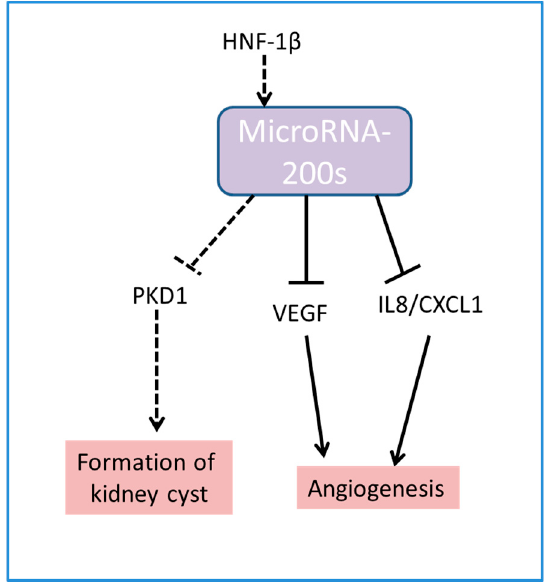
Figure 2. Schematic diagram showing miR-200s control cyst formation and angiogenesis. Dashed lines indicate the same pathway. HNF-1 β : hepatocyte nuclear factors 1 β , PKD1: polycystin I, VEGF: vascular-endothelial-growth factor, IL8: interleukin 8, CXCL1: chemokine (C-X-C motif) ligand 1.